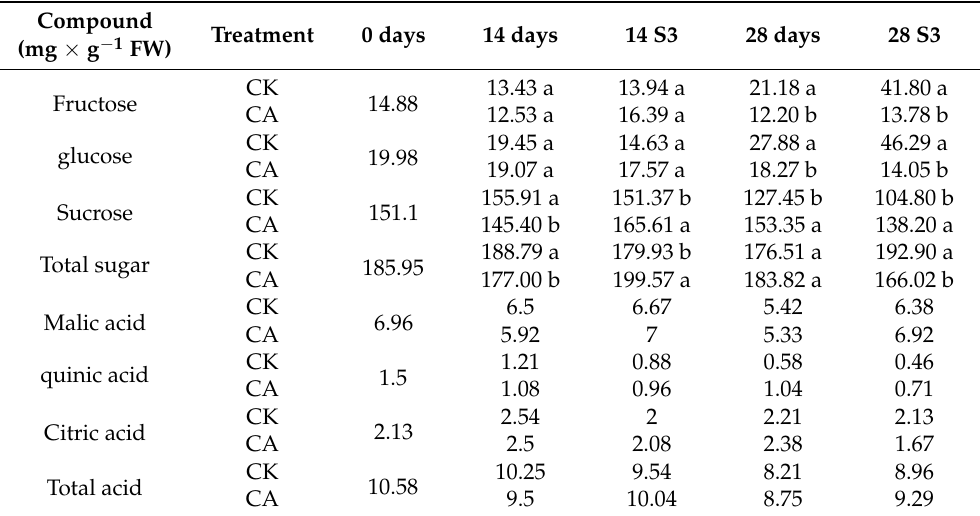
Table 1. The content of organic acids and soluble sugars in peach during cold storage plus three shelf-days at 20 ◦ C.